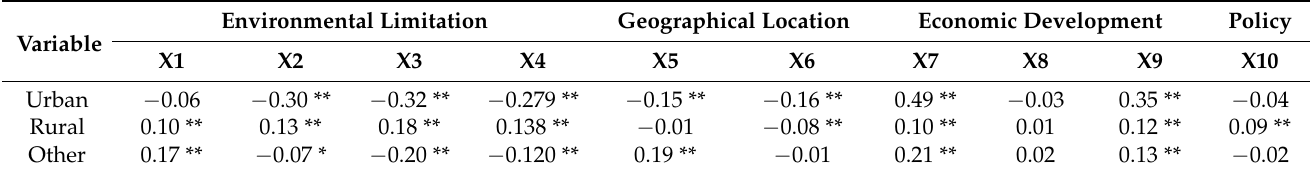
Table 3. Results of the driving factor